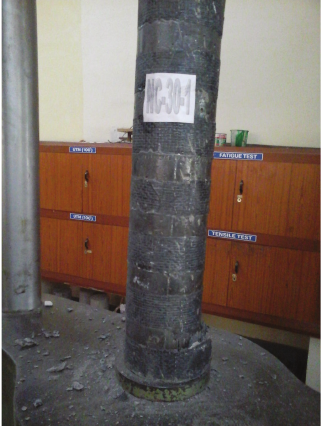
Figure 6: Failure pattern of